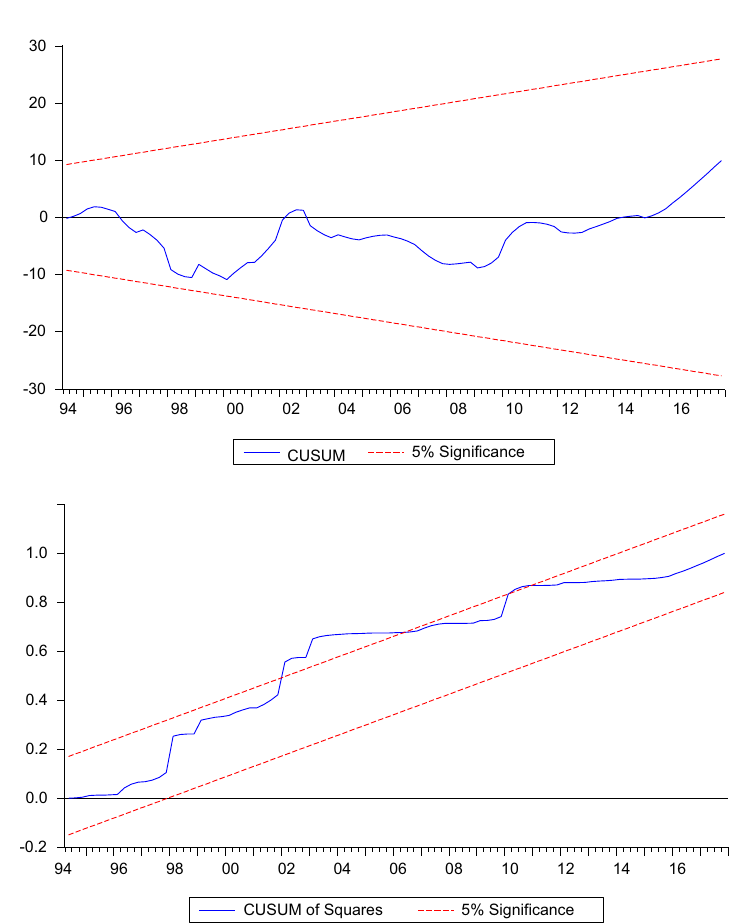
Fig. 9 CUSUM and CUSUMQ tests of ARDL